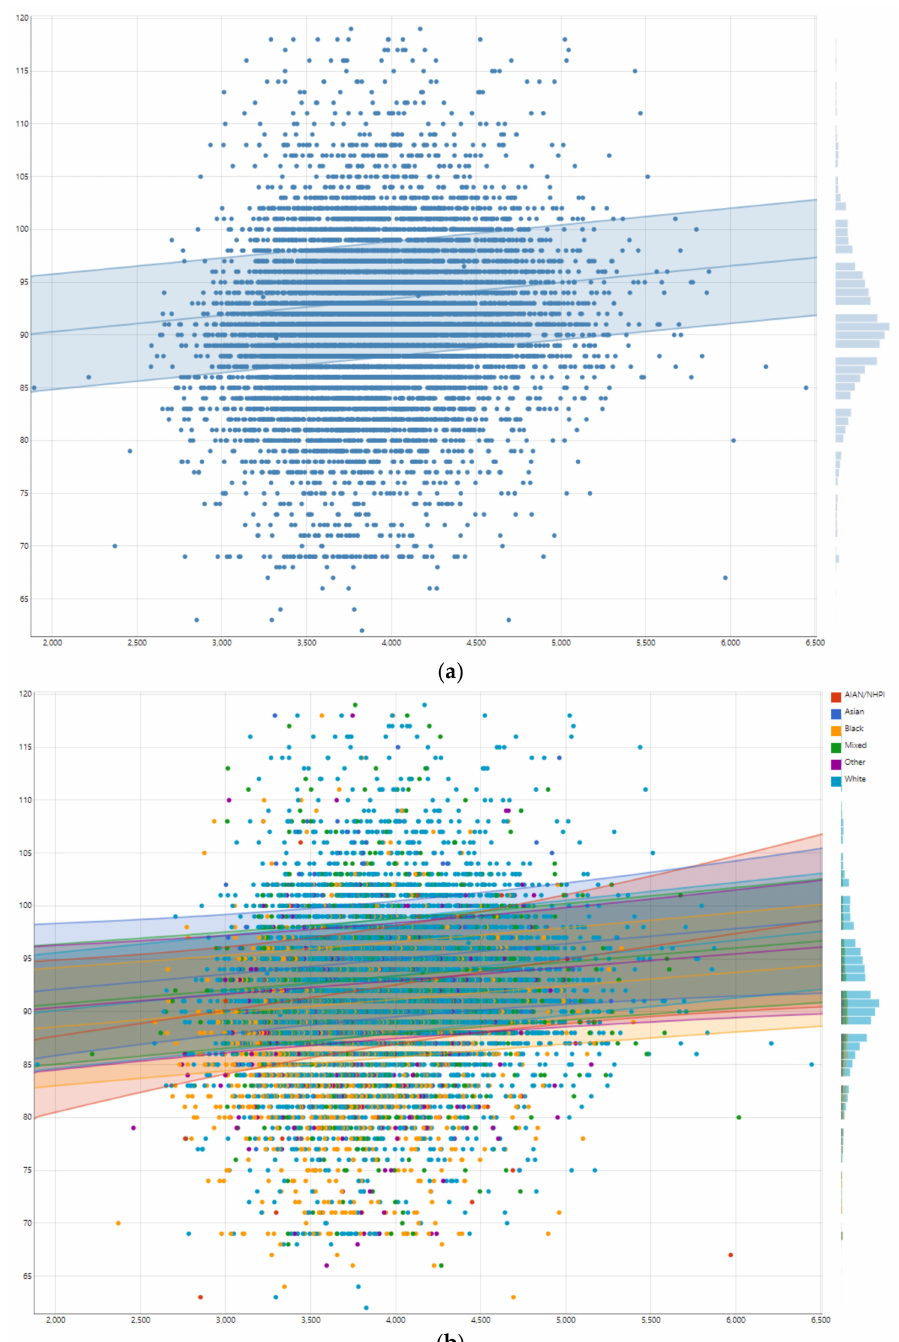
Figure A6. Association between the right superior temporal cortical surface area and children’s reading ability. In these figures, X represents children’s right superior temporal cortical surface area and Y represents children reading scores. ( a ) Overall; ( b ) by